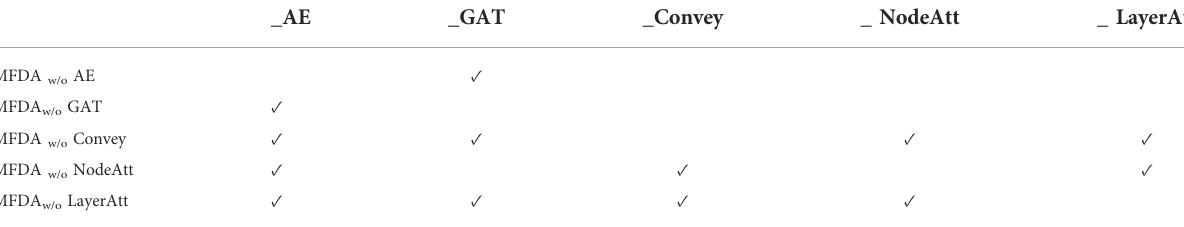
TABLE 5 Ablation variants